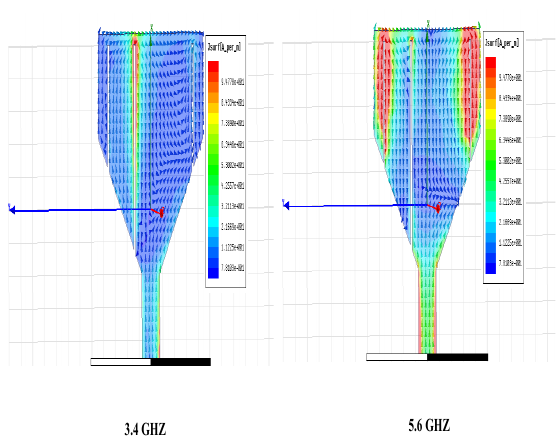
Figure 5: VSWR of the proposed antenna with and without slots.